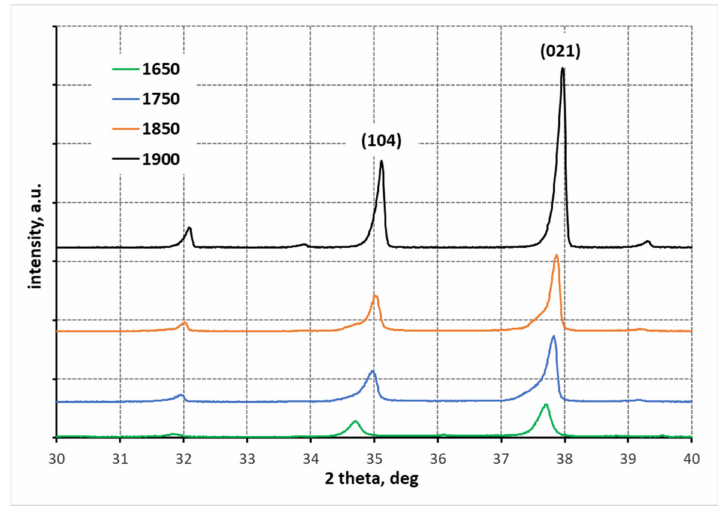
Figure 4. Fragment of X-ray diffractograms from 30 to 40 ◦ 2 theta (samples with B:C = 5:1).